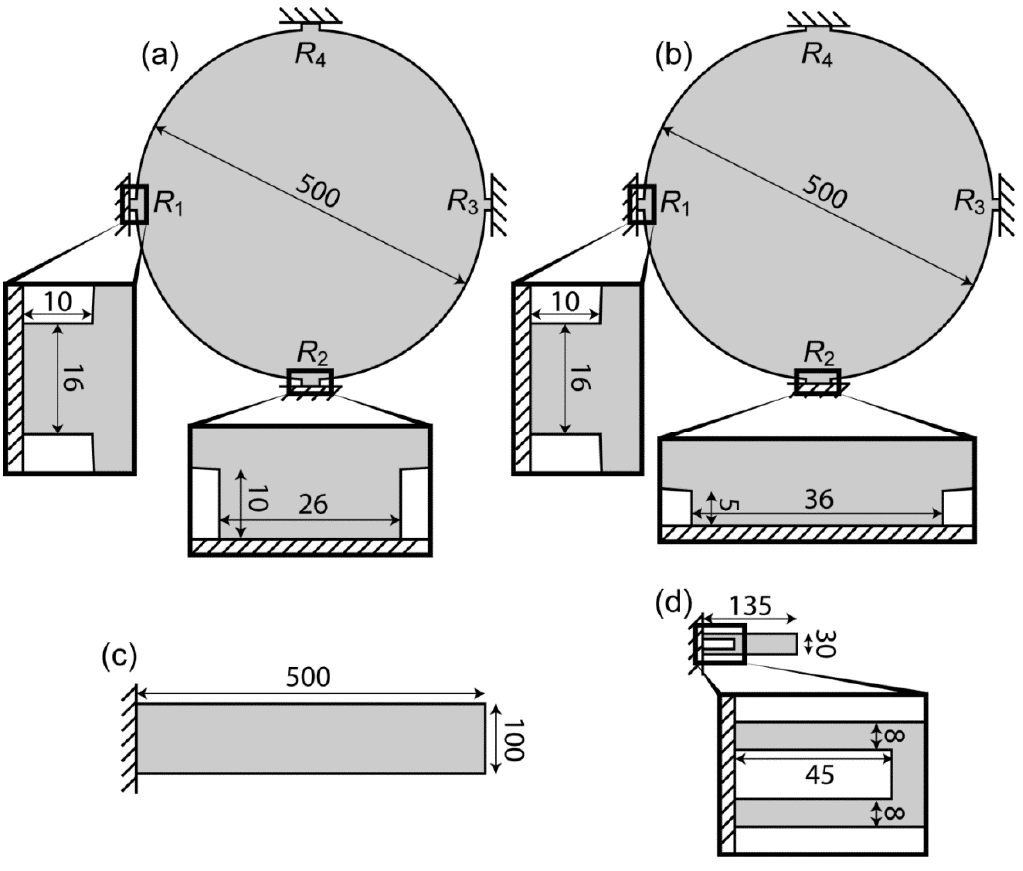
Figure 2. Dimensions of the sensors which are compared in the present study. All figures are illustrated in top-view. Numbers indicate the dimensions in μ m. ( a ) 2G-MSS (thickness 2.5 μ m); ( b ) 1G-MSS (thickness 3.2 μ m); ( c ) optically read-out cantilever (thickness 1 μ m); ( d ) piezoresistive cantilever (thickness 1 μ m) [14]. The piezoresistors-integrated parts are magnified in the insets. Note that R have the same dimensions,